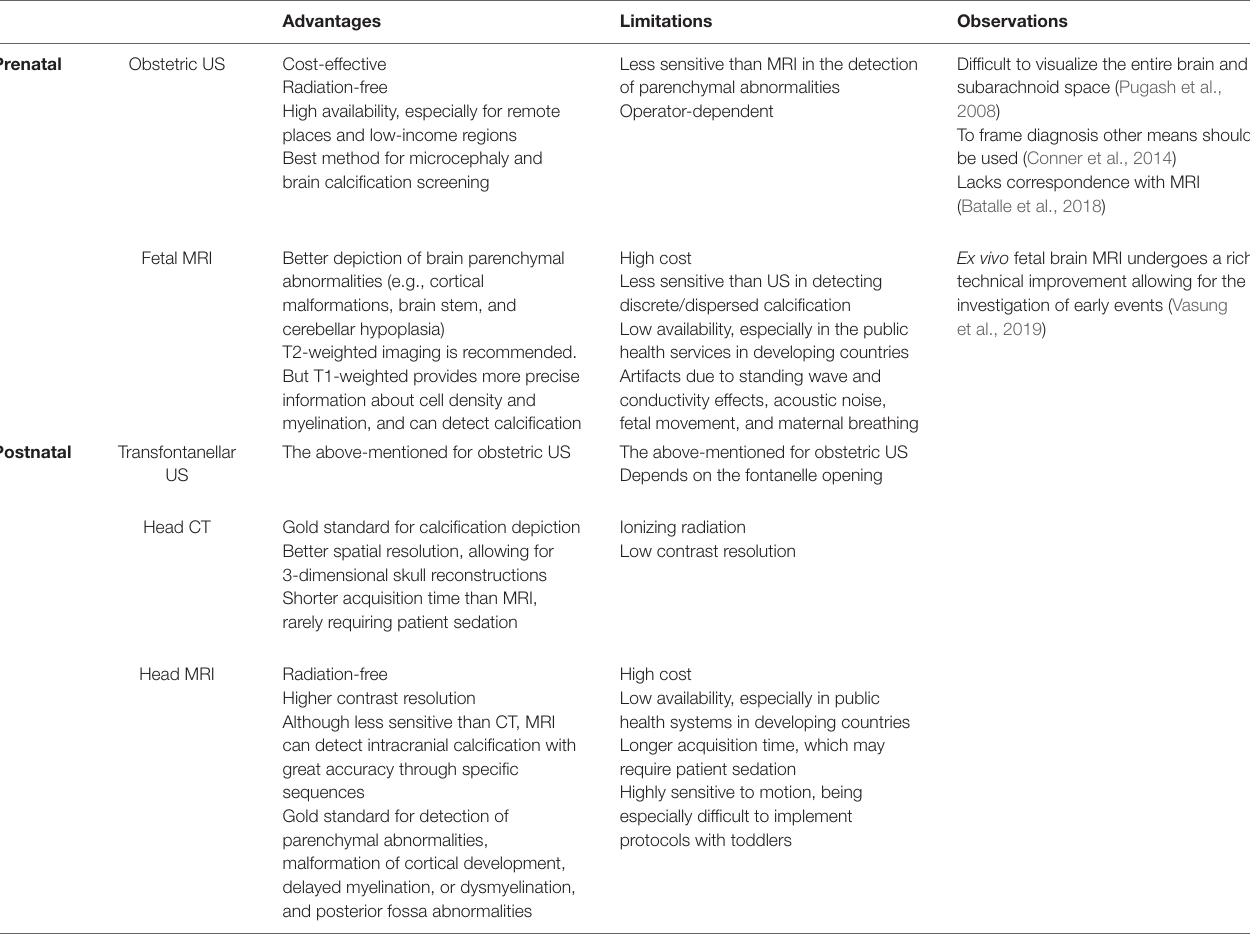
TABLE 2 | Brain imaging for clinical purposes: the main advantages and